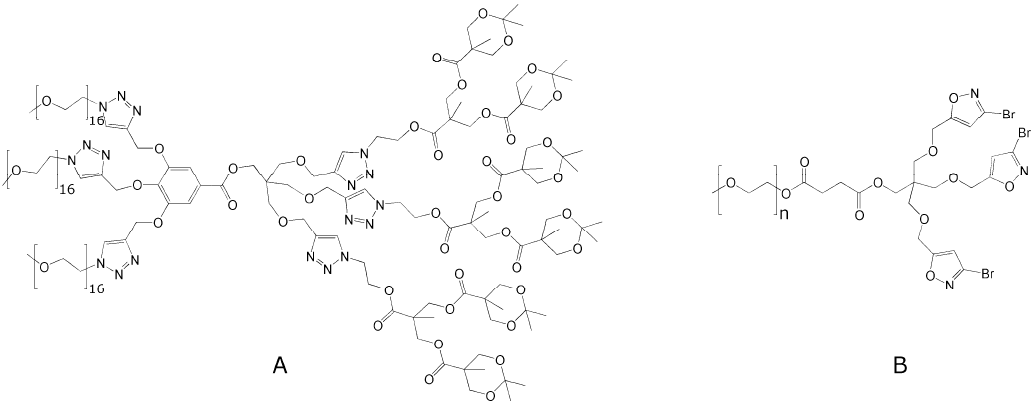
Figure 10. Structural outline of two architectural polymers. ( A ) A poly(ester) dendron and three PEG units [10]; and ( B ) PEG-isoxazole-based telodendrimer